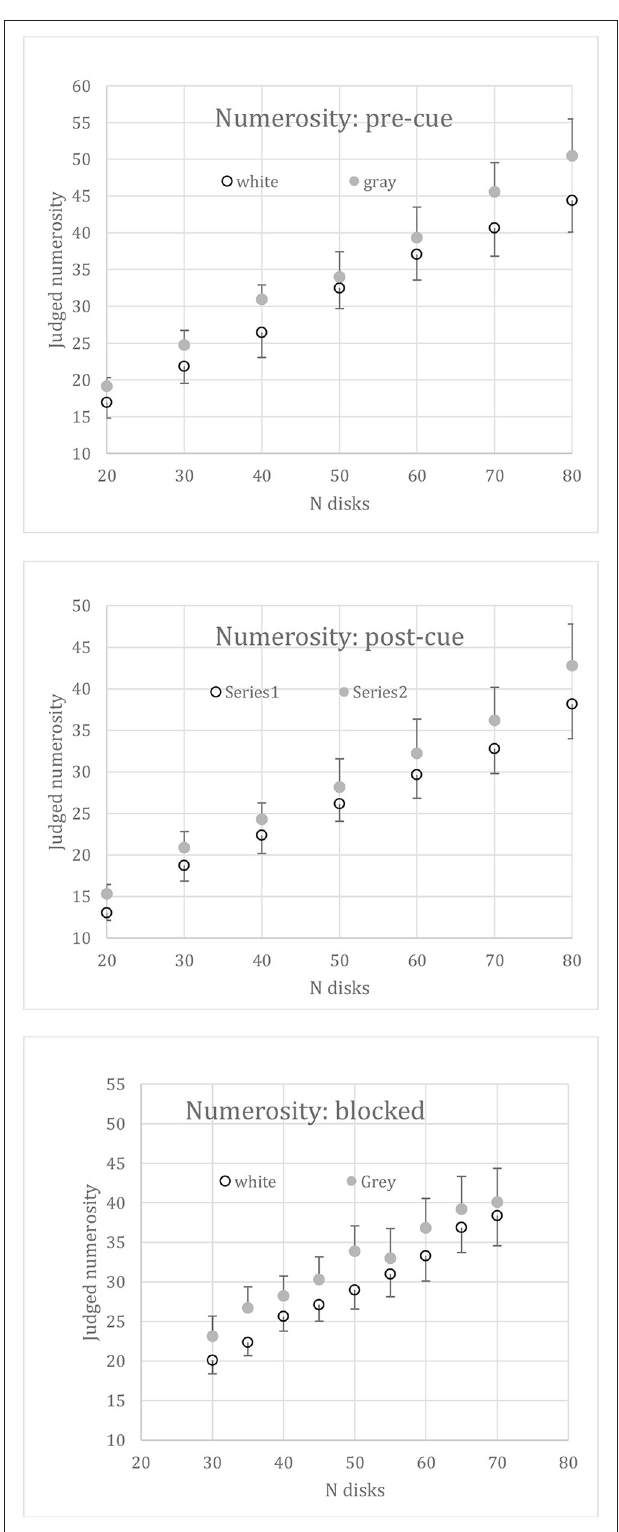
FIGURE 5 | Mean judged numerosity vs. set size (N) when disk sets were intermingled. i.e., both white and gray disks appeared together on each trial. Top: the target set (i.e., the set to be judged) was randomized but pre-cued. Middle: the target set was randomized but post-cued. Bottom: target set was blocked. Error bars: 1SE for gray disks, 1SE for white + −